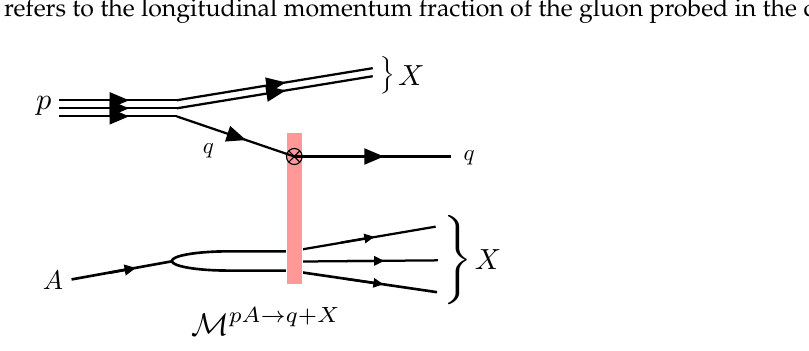
Figure 5. Feynman diagram for the amplitude collisions. A light-like Wilson line appears in the amplitude; thus, the cross section will feature a dipole